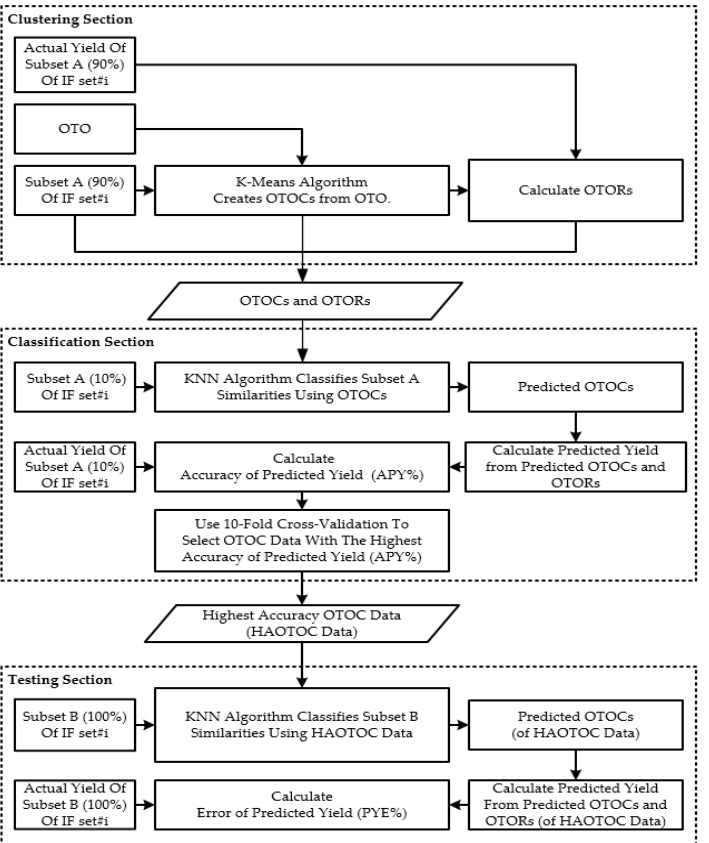
Figure 10. Conceptual framework of the Input Factor Similarity Relationship Method (OTO = Optimal Target Output, OTOC = Optimal TO Cluster, OTOR = Optimal TO